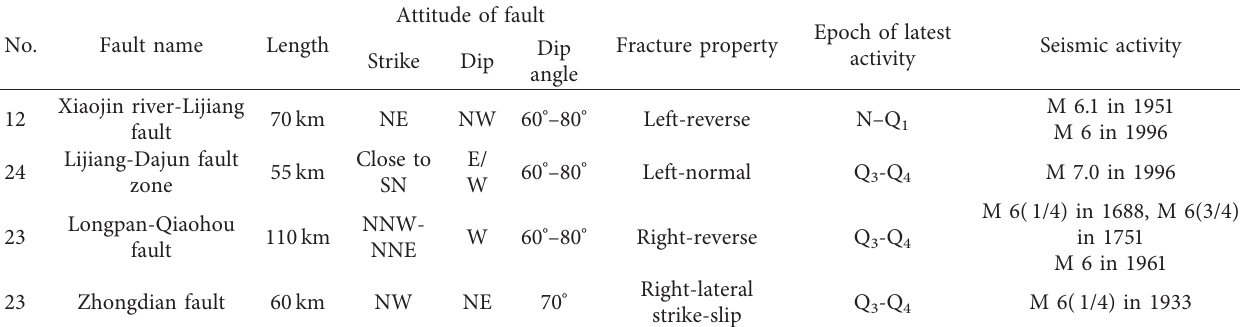
Table 2: The main characteristics of active faults along the Lijiang to Shangri-La railway from south to north.